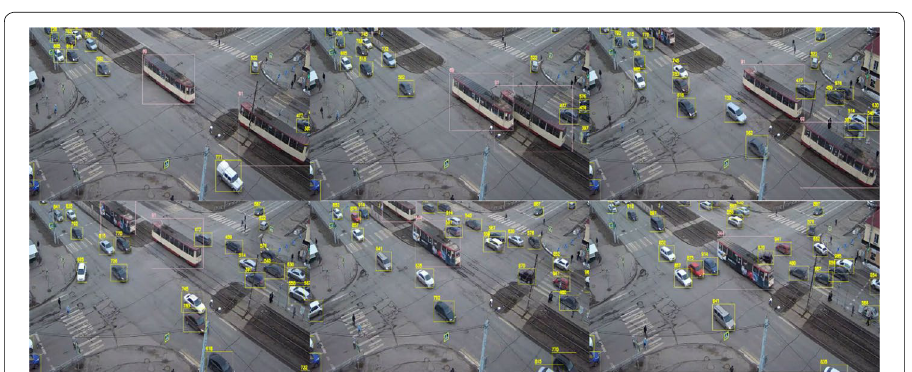
Fig. 10 The result of the tracker